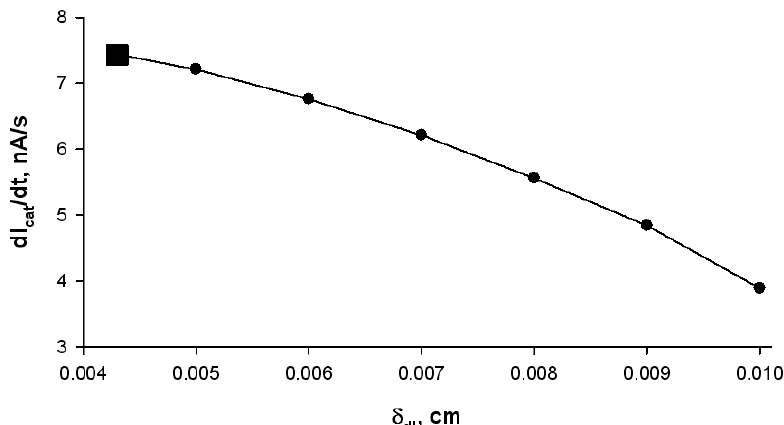
Figure 3. Dependence of the initial rate of AAP bioelectrocatalytic oxidation current increase on the AA diffusion layer thickness d The indicated data point at the lowest value of d and [S] = 1.7×10 -11 mol cm -2 were 0